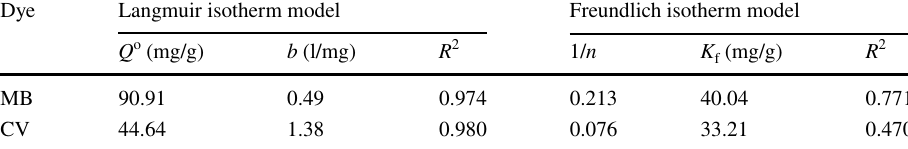
Table 1 Calculated equilibrium Dye Langmuir isotherm model Freundlich isotherm constants for adsorption of CV on composite